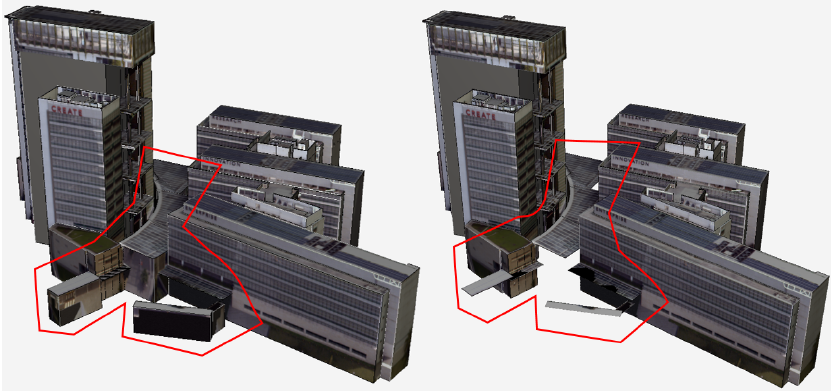
Figure 20. Deleting faces for shelters in the